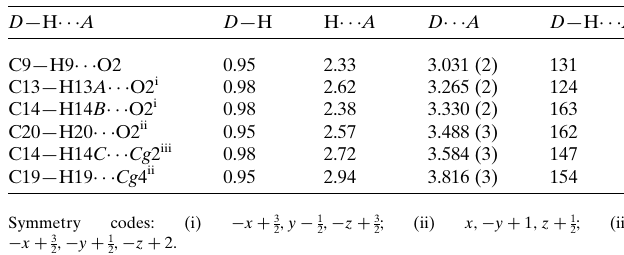
Table 1 Hydrogen-bond geometry (A˚ , (cid:2) ).